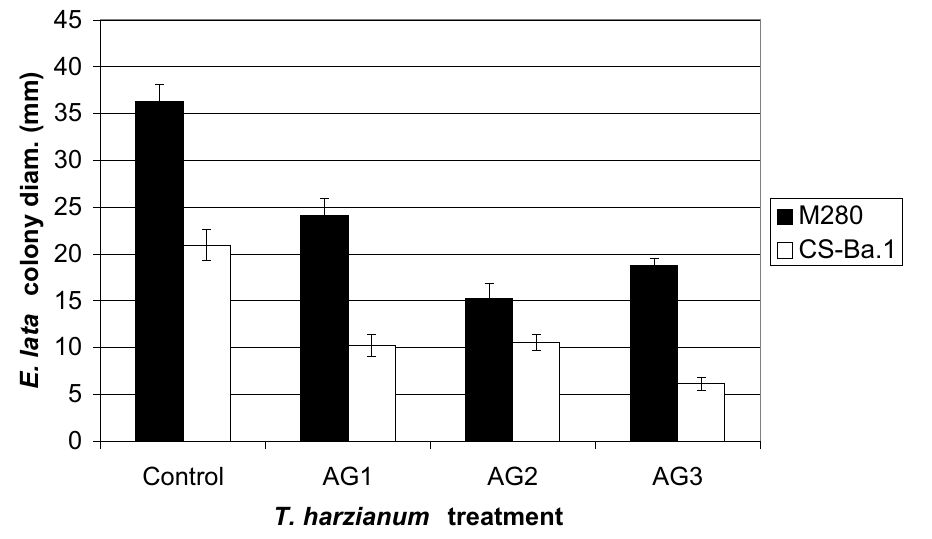
Fig. 1. Inhibition of growth of two isolates of E. lata on PDA due to volatile antibiosis by T. harzianum . Mycelial plugs of T. harzianum were grown on PDA for 2 days in the dark at 22–25°C. Bases of PDA plates inoculated with E. lata were inverted over the bases of plates containing the antagonist and incubated for 5 days. Y-axis denotes the average colony diam. (minus the inoculum plug) for eight replicates per treatment. Bars denote standard